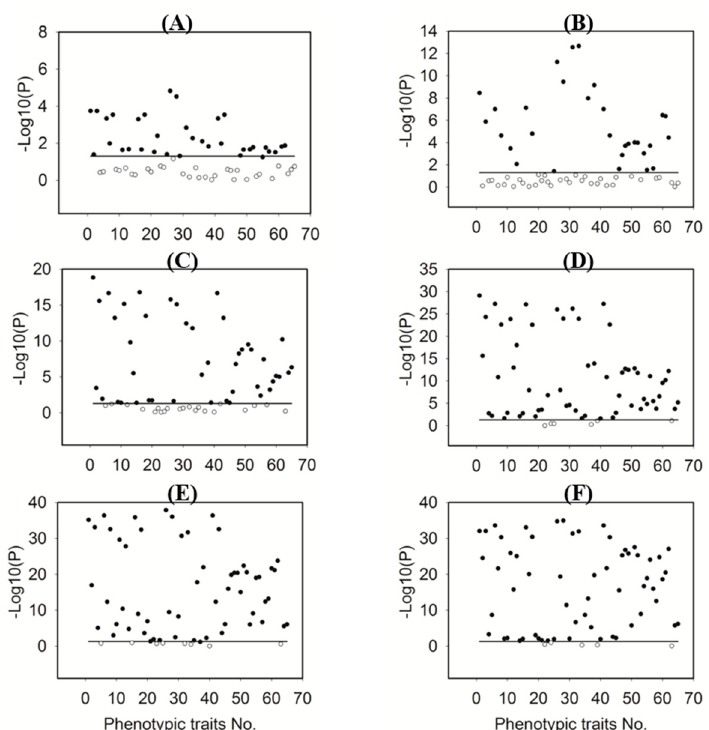
Figure 4. Significance analyses of phenotypic features with a p-value threshold of 0.05. The phenotypic features are indicated using numbers corresponding to their names. The solid horizontal line represents p = 0.05, i.e., − log10 (p) = 1.301. The solid and hollow circles indicate the conditions p < 0.05 and p > 0.05, respectively. ( A ), ( B ), ( C ), ( D ), ( E ), ( F ) corresponding to 7, 14, 21, 28, 35, and 42 days after the first N application, respectively.